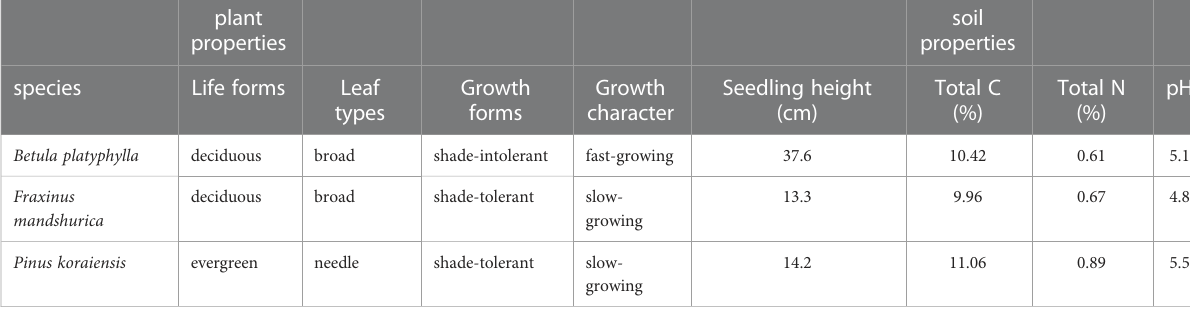
TABLE 1 Characterization of plant material and soil properties in